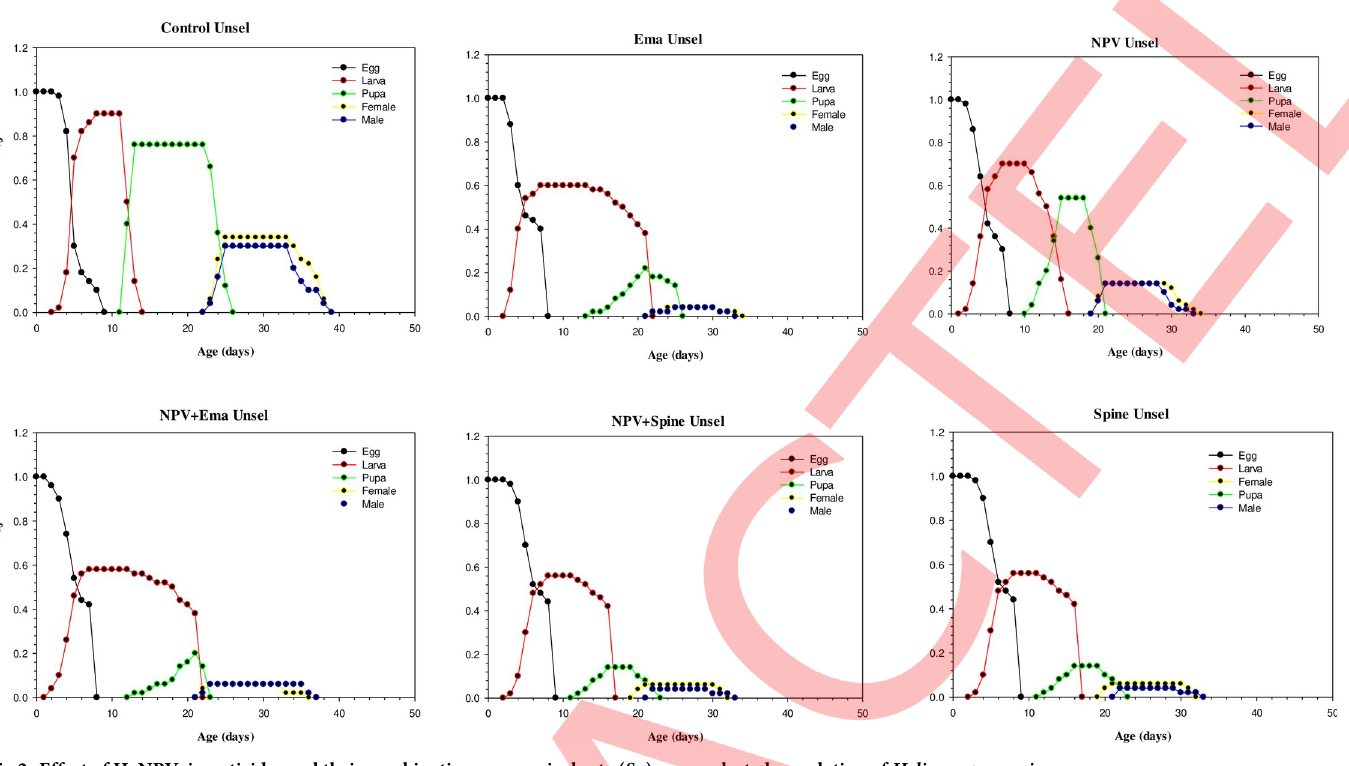
Fig 2. Effect of HaNPV, insecticides and their combinations on survival rate ( S